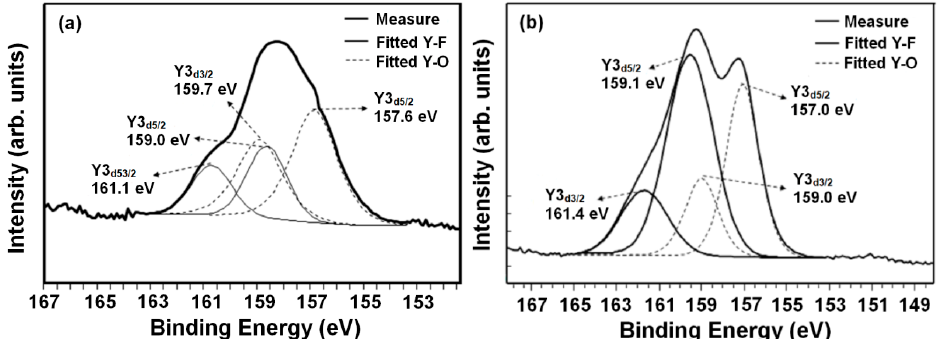
Figure 6. Variations of chemical compositions measured by X-ray photoelectron spectroscopy (XPS) with the sputtering times of ( a ) YOF and ( b ) YF 3 coatings.